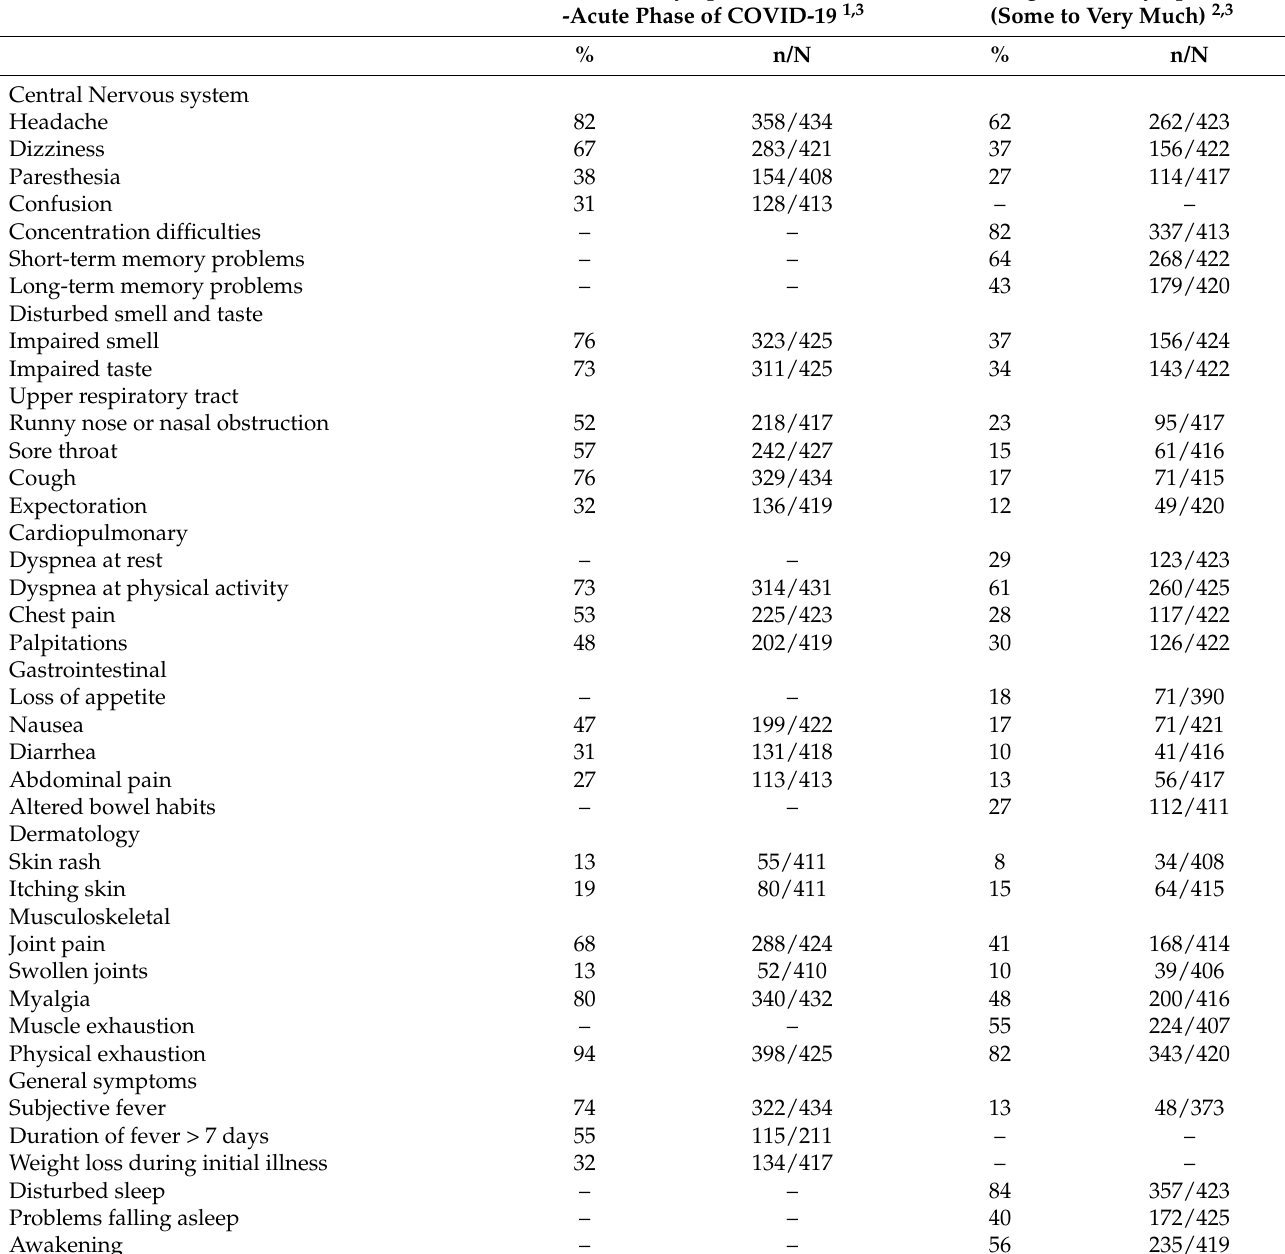
Table 2. Patient-reported new onset symptoms and standardized health scale results in patients in a post-COVID clinic.